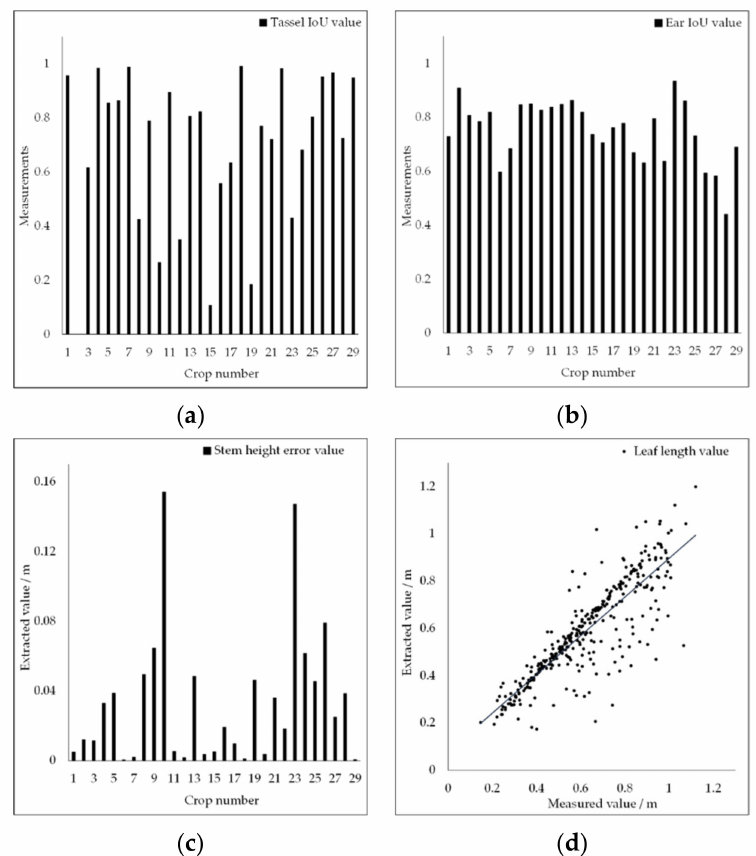
Figure 14. Clustering accuracy analysis of maize organs. ( a ) Column chart of IoU value of maize tassel; ( b ) Column chart of IoU value of maize ear; ( c ) Column chart of maize stalk height error value; ( d ) Scatter plot of maize leaf length.